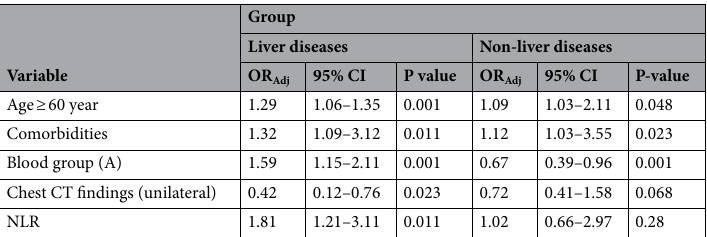
Table 3. Multivariate logistic regression of factors associated with progression of disease in patients with underlying liver diseases and without underlying liver diseases. OR Adj Odds ratio adjusted, 95% CI 95% confidence interval, NLR neutrophil-to-lymphocyte